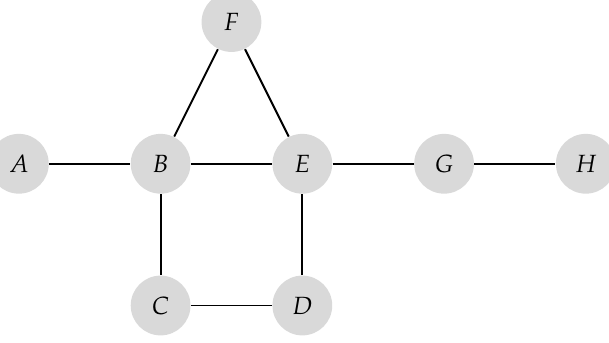
Figure 1. Example of a